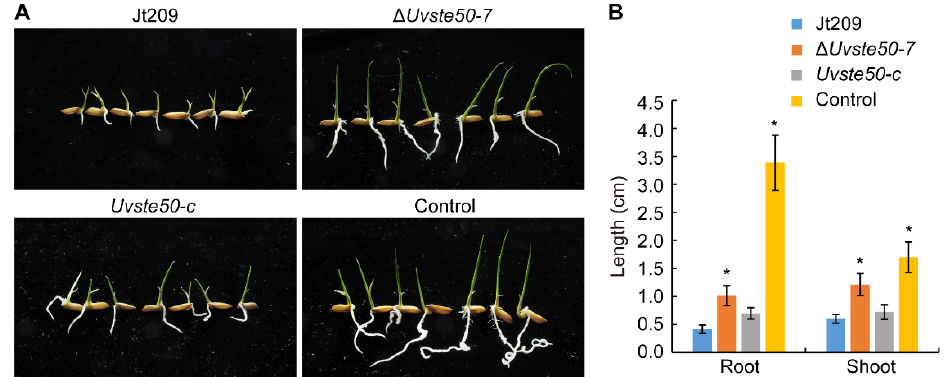
Figure 5. Assays for toxicity of U. virens culture filtrates with rice seeds. ( A ) Seeds of rice cultivar Liangyoupeijiu were incubated on sterile filter papers soaked with filtrates of 5 ‐ day ‐ old PSB cul ‐ tures of the wild ‐ type strain Jt209, Δ Uvste50 mutant, and the complemented strain Uvste50 ‐ c . Shoot